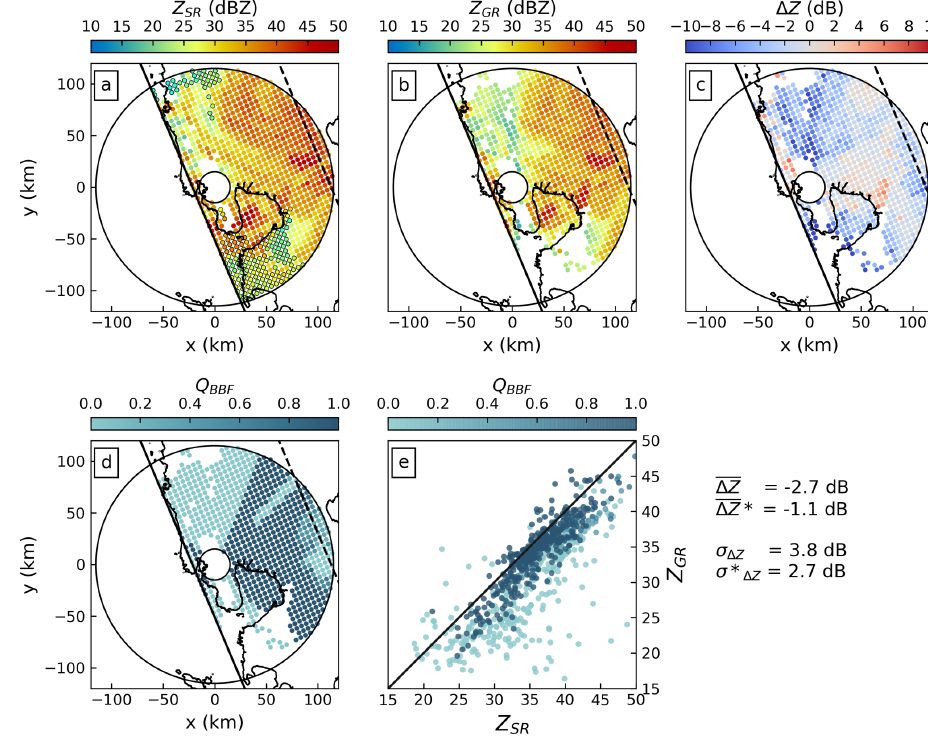
Figure 7. As in Fig. 5 but for the overpass on 1 October 2015. The mean bright band level is found at 4719m for this case.